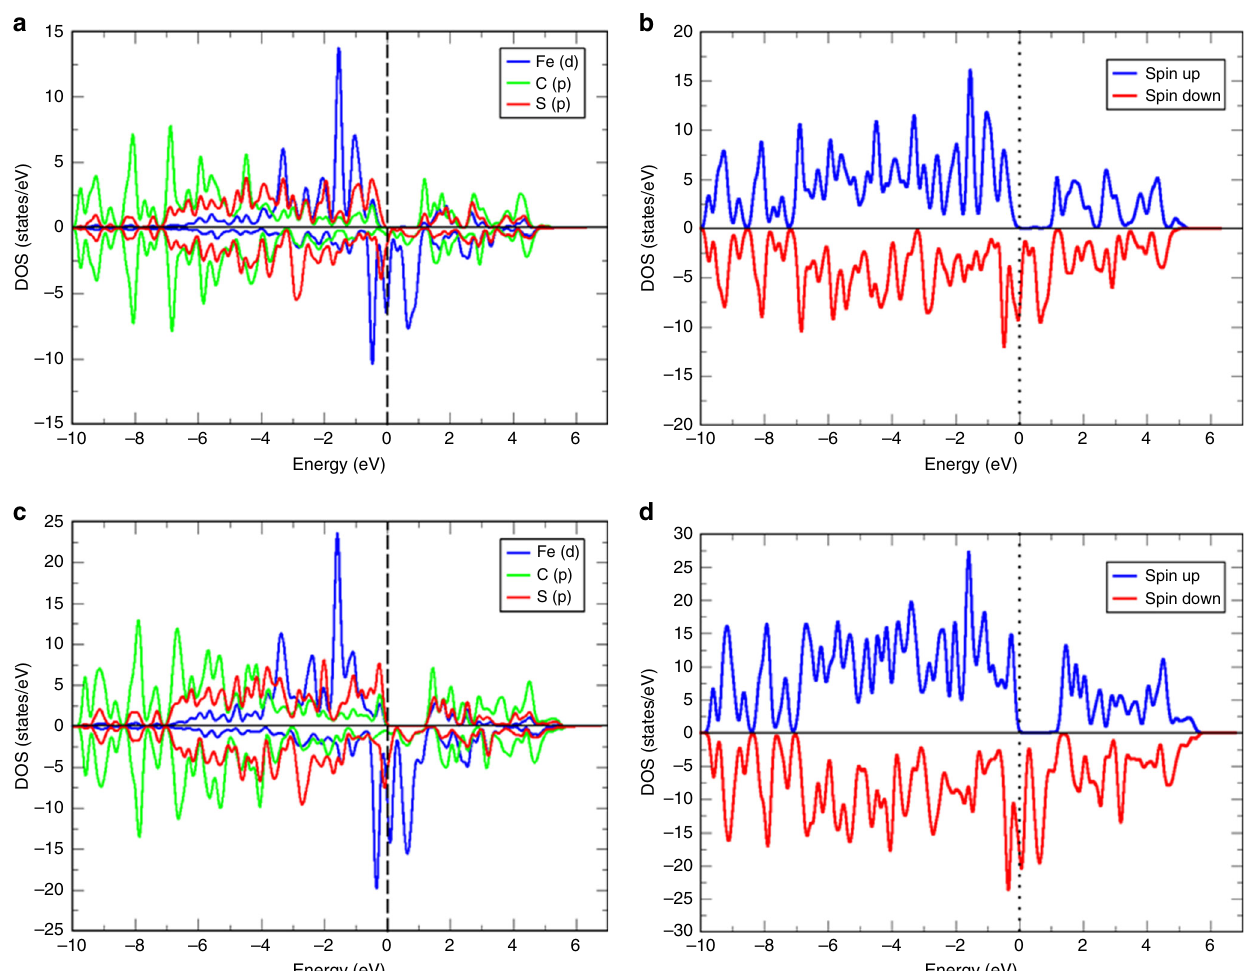
Fig. 3 Electronic band structure of PTC-Fe near the Fermi level. a Total density of states (DOS) for a single layer. b Spin up/Spin down for a single layer. c Total DOS for AB stacking. d Spin up/Spin down for AB